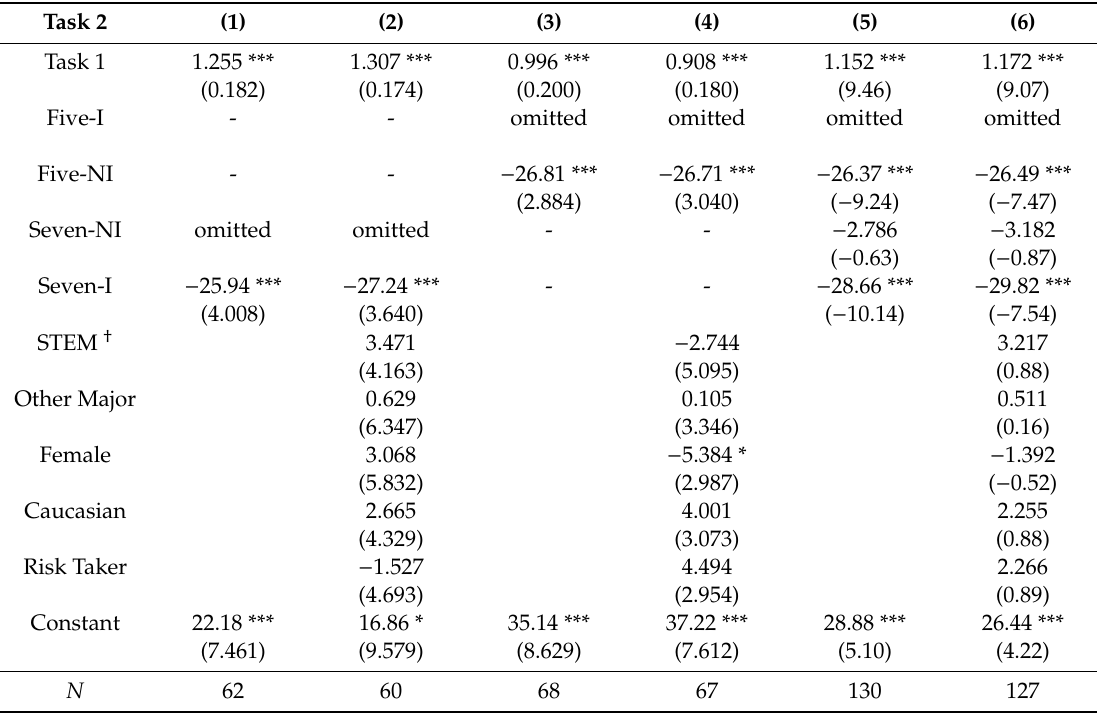
Table 2. Ordinary Least Squares Regression on E ff ort in the Second